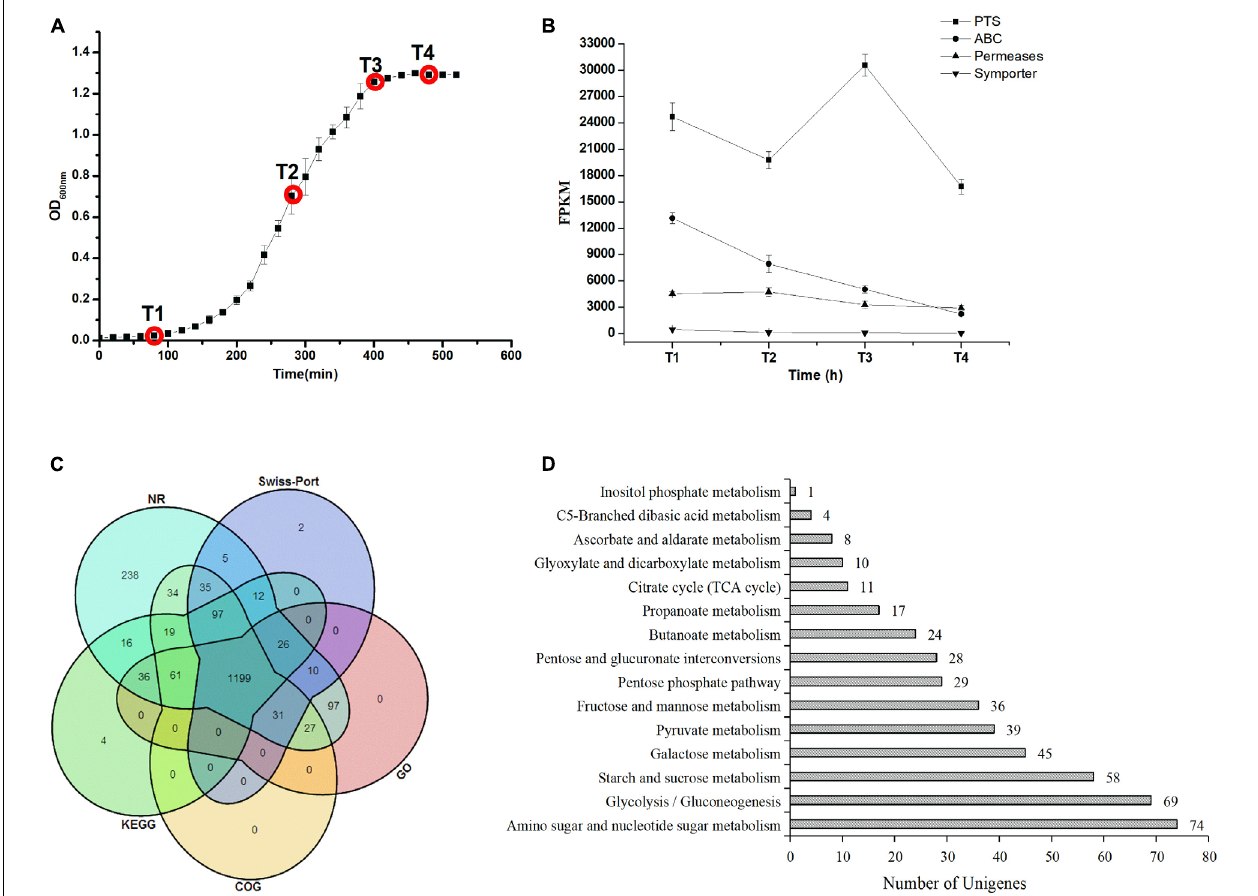
FIGURE 1 | (A) Growth curve and sampling points during the ST-MZ-2 culture. (B) Changes in the FPKM of four carbohydrate transport systems during ST-MZ-2 culture. (C) Venn diagram of the unigenes annotated to the NR, Swiss-Prot, KEGG, COG, and GO. (D) The numbers of unigenes annotated to carbohydrate metabolic